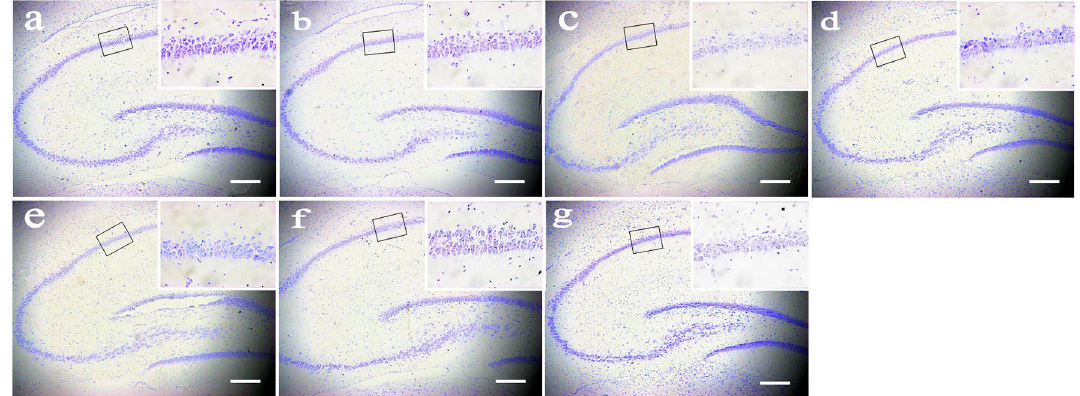
Figure 4. Nissl’s staining in the cerebral motor cortex of rats in each group. ( a ) control group, ( b ) NE group, ( c ) REIA group, ( d ) 3 d AA group, ( e ) 1 week AA group, ( f ) 2 weeks AA group, ( g ) MTI group. Scale bar = 100